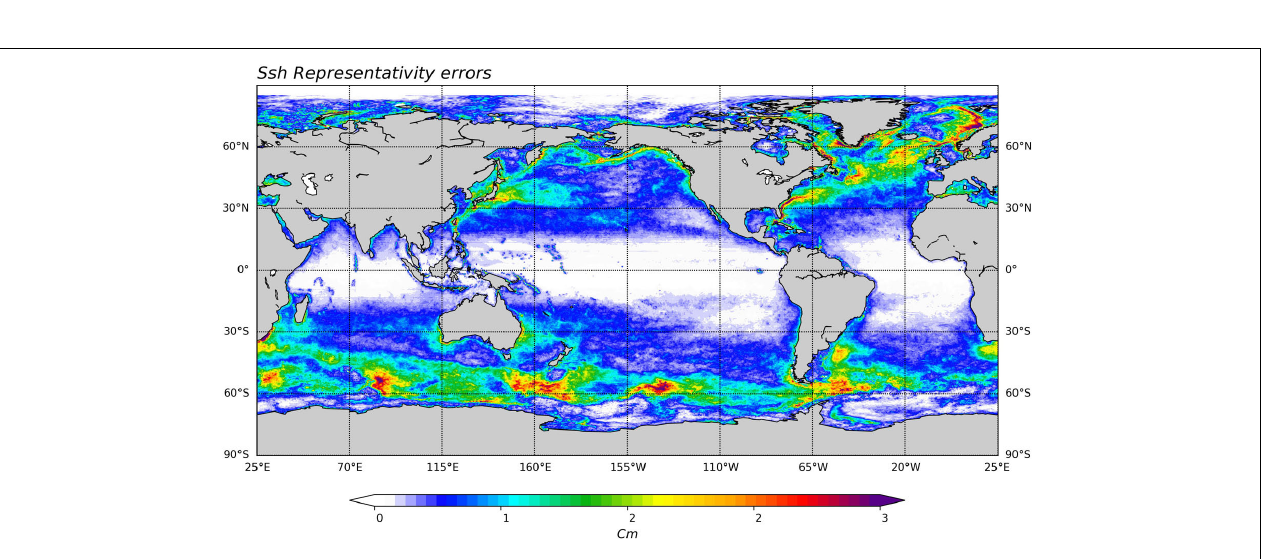
FIGURE 8 | SSH representativity error